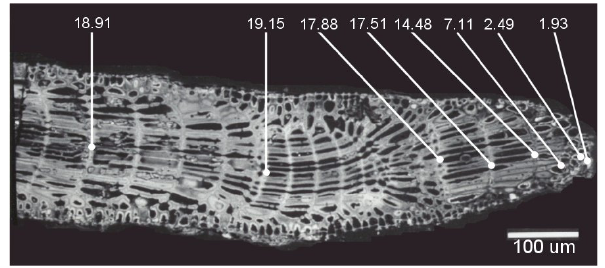
Fig. 22. Backscatter electron image of a longitudinal section through the tip of the branching coralline alga Amphiroa sp. A reared in seawater with the estimated Late Cretaceous Mg/Ca ratio of 1.0. Numbers are mole percentages of magnesium in substitution for calcium in cell wall calcite. Measurements are at junctures of four cells along cell rows, one of which is added daily. Percentages in the 17.51 to 19.15 range are for calcification in modern seawa- ter. During 4 days of growth in the Late Cretaceous experimental seawater, the percentage of Mg progressively declined, ultimately reaching 1.93 (low Mg calcite; from Stanley et al.,